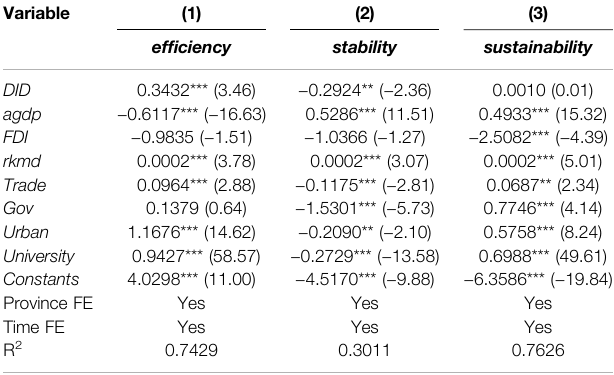
TABLE 5 | Regression analysis of three indicators of economic growth quality.